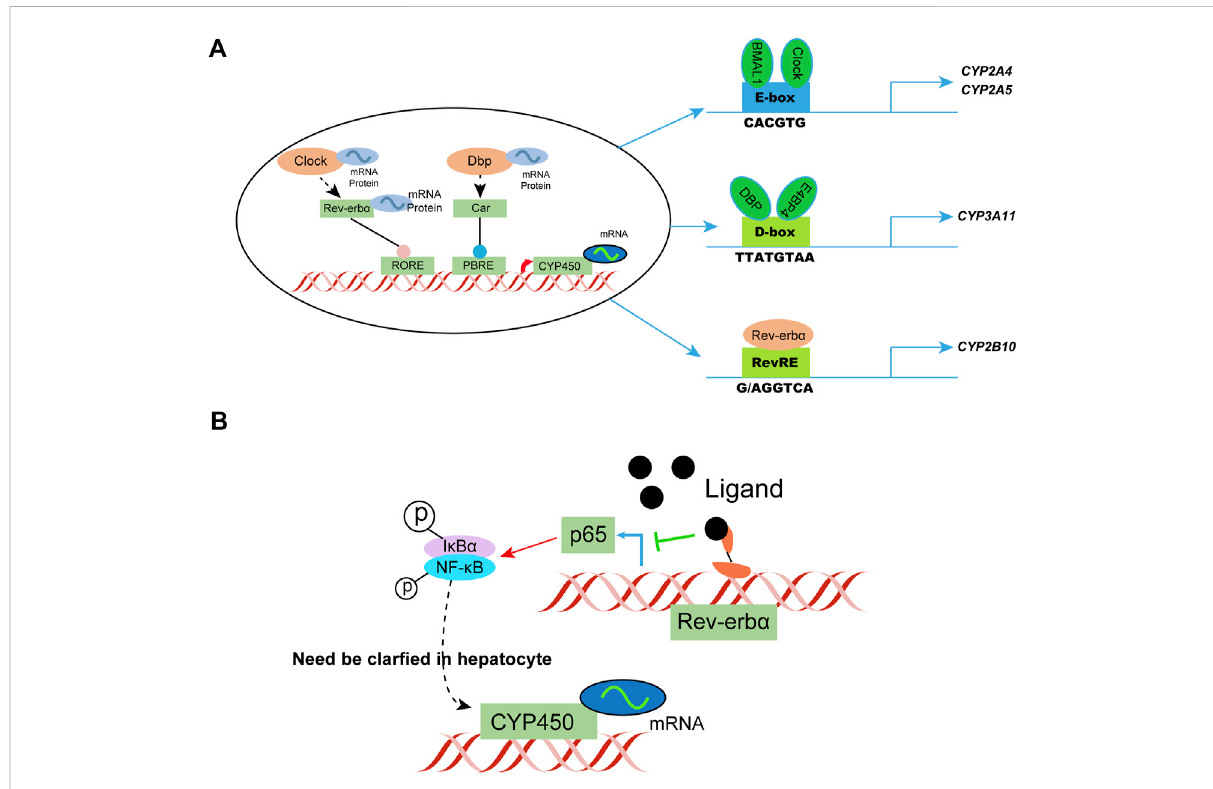
FIGURE 4 Circadian clock-controlled drug metabolism. (A) Molecular mechanisms of circadian clock regulation of CYP450; (B) Possible circadian clock regulation of CYP450 in hepatocytes in a state of in fl ammation. I κ B α , I kappa B